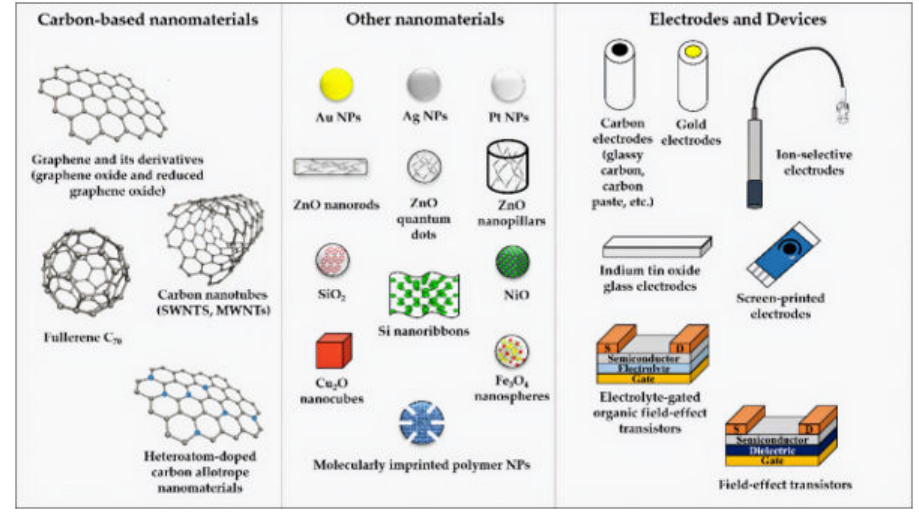
Figure 7. Schematic illustration of carbon allotrope nanomaterials and other nanomaterials together with electrochemical and electronic tools described in this